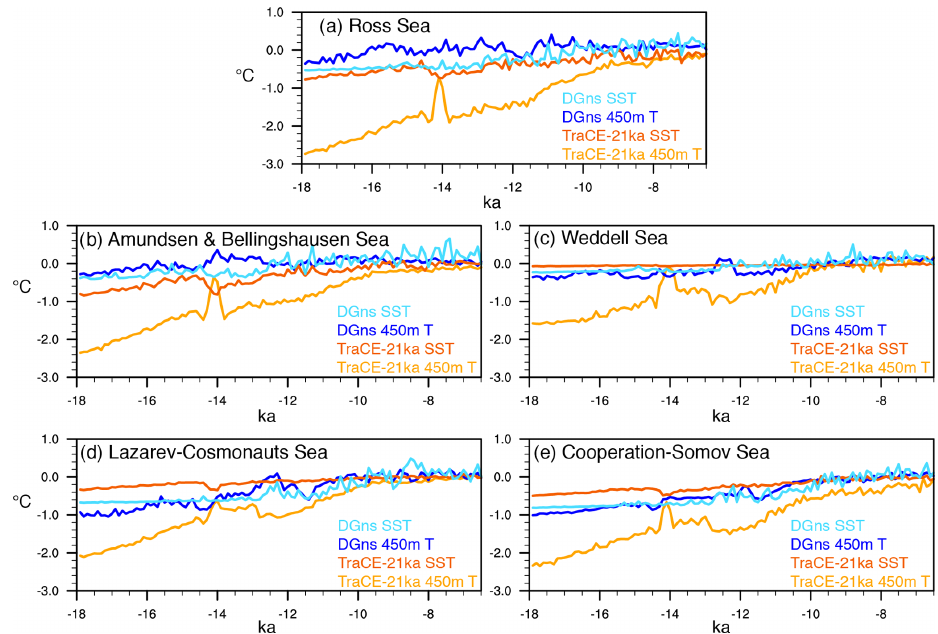
Figure 7. Time series of 100-year mean annual average SST and 450m depth ocean temperature anomalies relative to the pre-industrial era ( ◦ C) of the coastal seas around Antarctica, namely (a) the Ross Sea (70–62 ◦ S, 168 ◦ E–160 ◦ W), (b) the Amundsen and Bellingshausen Sea (68–62 ◦ S, 135–60 ◦ W), (c) the Weddell Sea (70–62 ◦ S, 60–30 ◦ W), (d) the coastal region from Lazarev Sea to Cosmonauts Sea (67–62 ◦ S, 15 ◦ W–50 ◦ E), and (e) the coastal region from Cooperation Sea to Somov Sea (67–62 ◦ S, 55–165 ◦